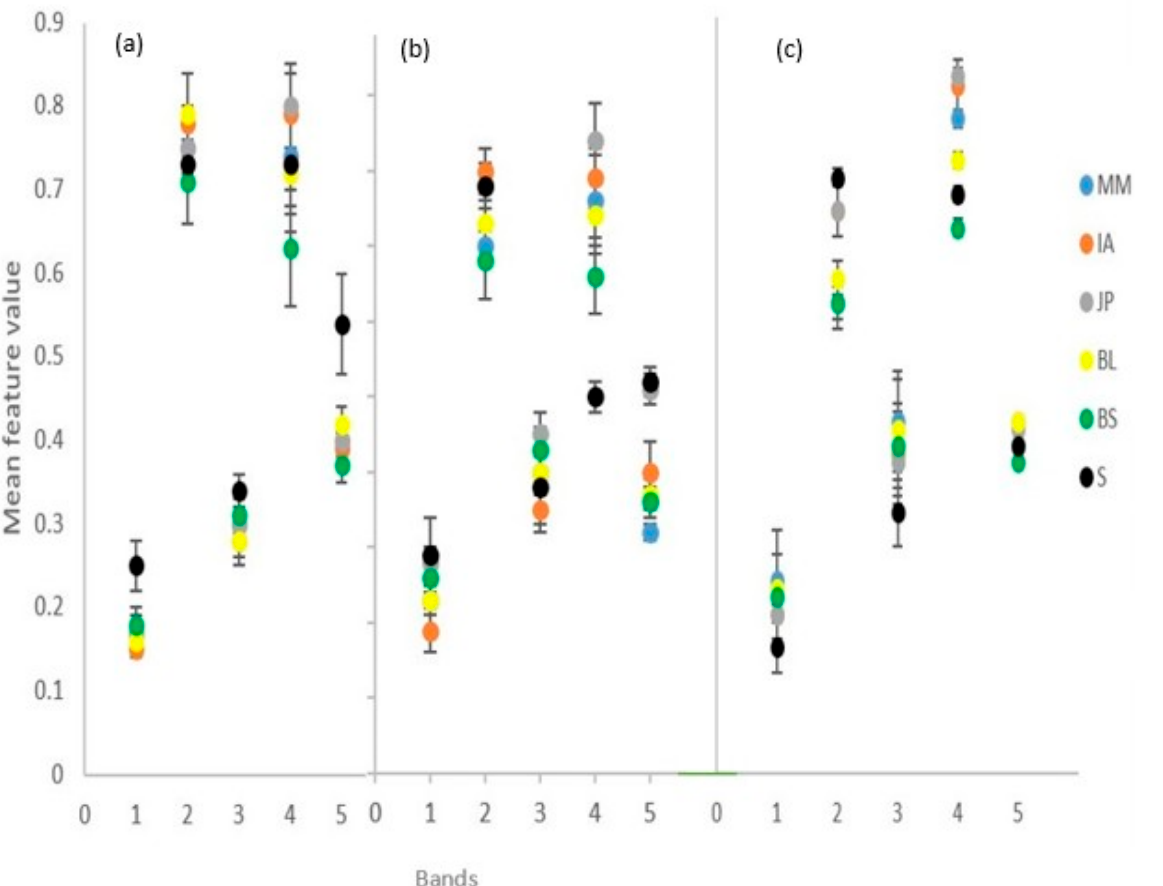
Figure 7. Species separability in GLCM texture bands (1, contrast; 2, correlation; 3, dissimilarity; 4, entropy; and 5, standard deviation): ( a ) 25.05.22 image, ( b ) 15.08.21 image; and ( c ) 24.10.21 image. S = shadow